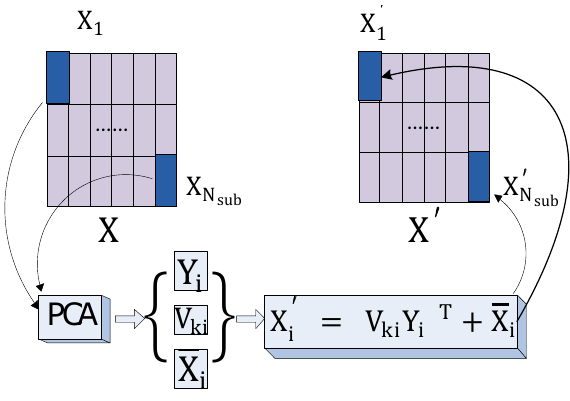
Figure 2. Feature extraction and reconstruction of original data with modular